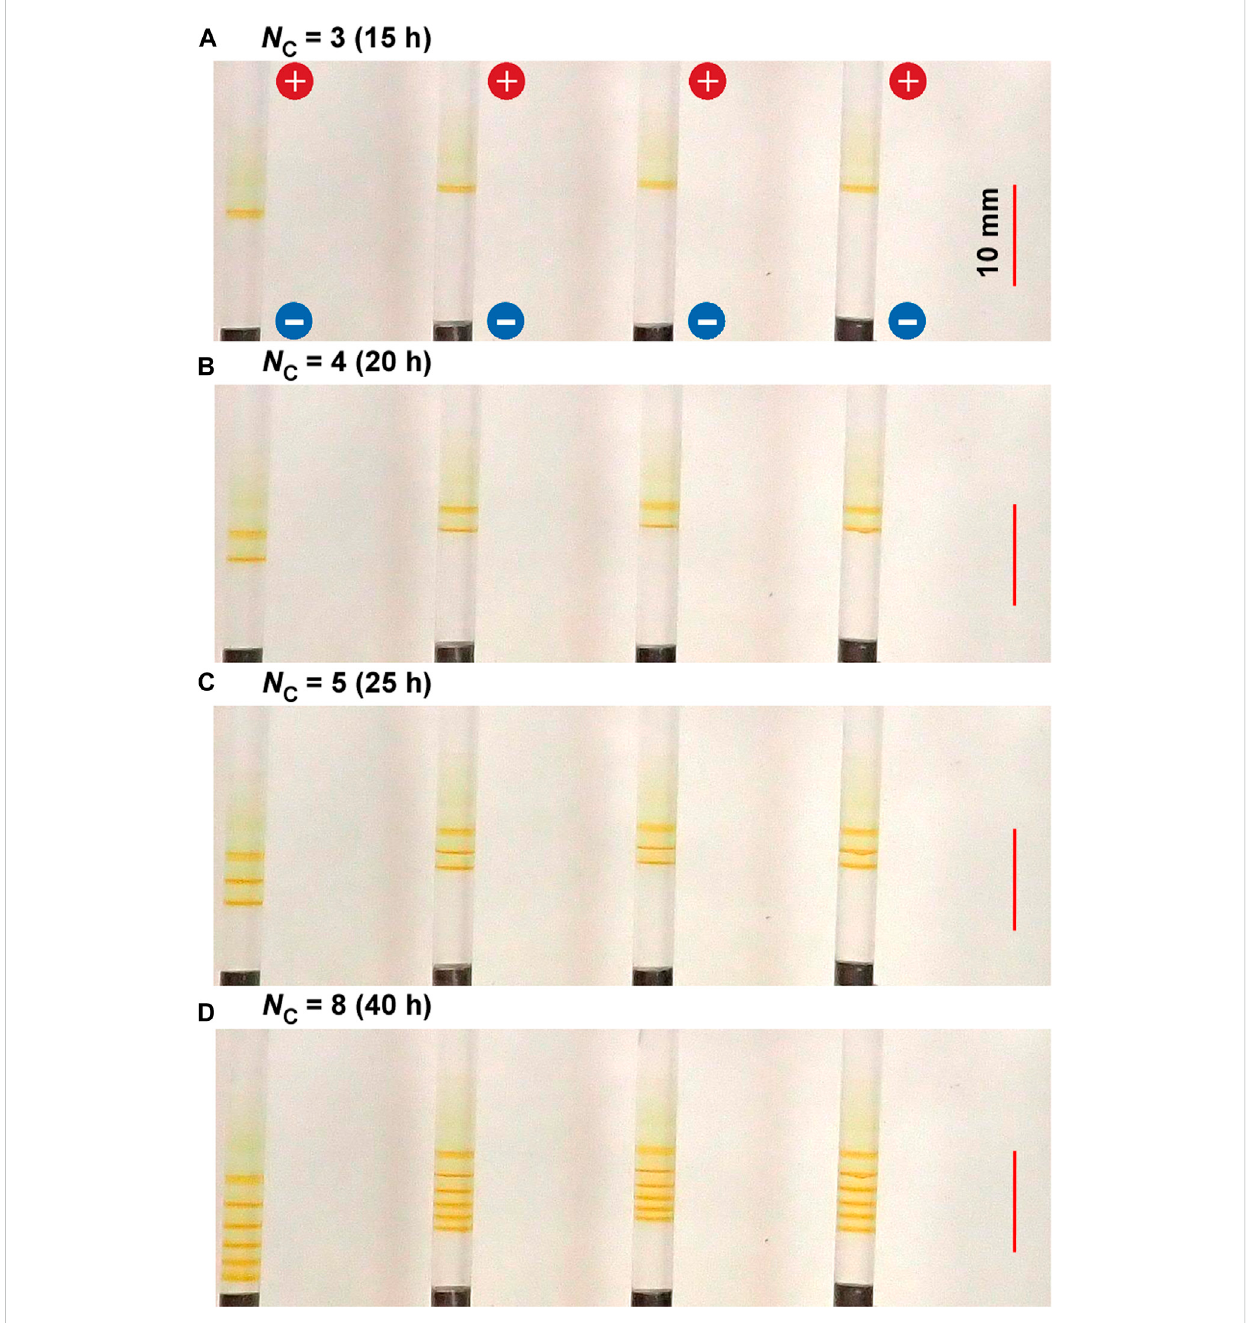
FIGURE 3 Spatiotemporal evolution of typical periodic bands formed in the four gel columns with L = 50 mm at 25 ° C under the following applied cyclic alternating voltage condition: E H = 3 V, E L = 1 V, T H = 1 h, and T L = 4 h. The cycle numbers ( N C ) are (A) 3 (B) 4 (C) 5, and (D) 8. The elapsed times after the applicationofvoltagearealsoindicated.Thescalebarsareprovidedontherightpartsoftheimages,andthechargesoftheelectrodesareprovidedinthe top